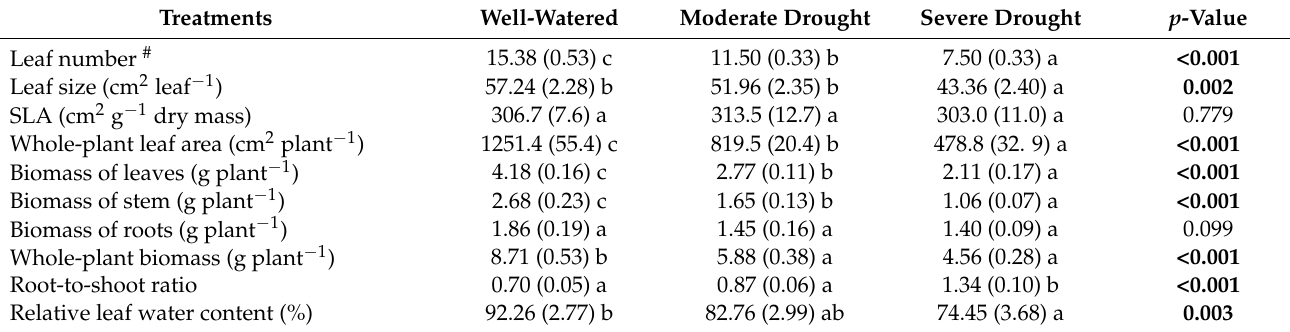
Table 1. Leaf area and biomass of poplar (hybrid T89) in response to moderate and severe drought stress and well-watered conditions. Data show means (SE) of n = 8. Different letters indicate significant differences of means at p ≤ 0.05, (one-way ANOVA, Tukey post-hoc test). SLA = specific leaf area.